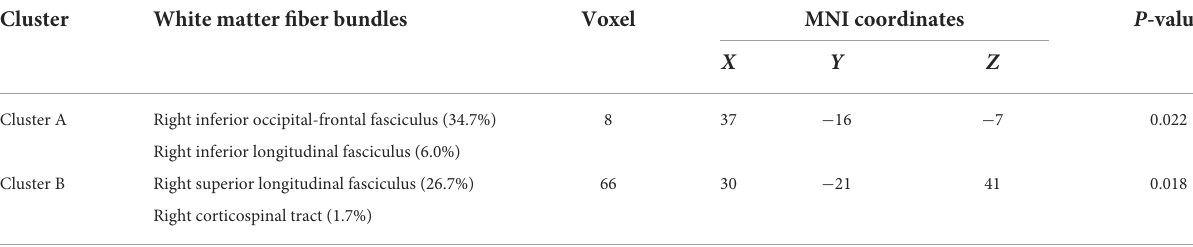
TABLE 2 Main effect of genotype on FA among the four groups.